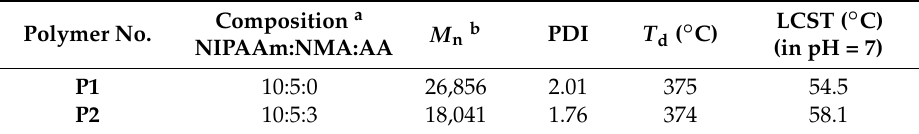
Table 1. Polymerization conditions and molecular weights of poly(NIPAAm- co -NMA- co -AA) random copolymers. Polymer